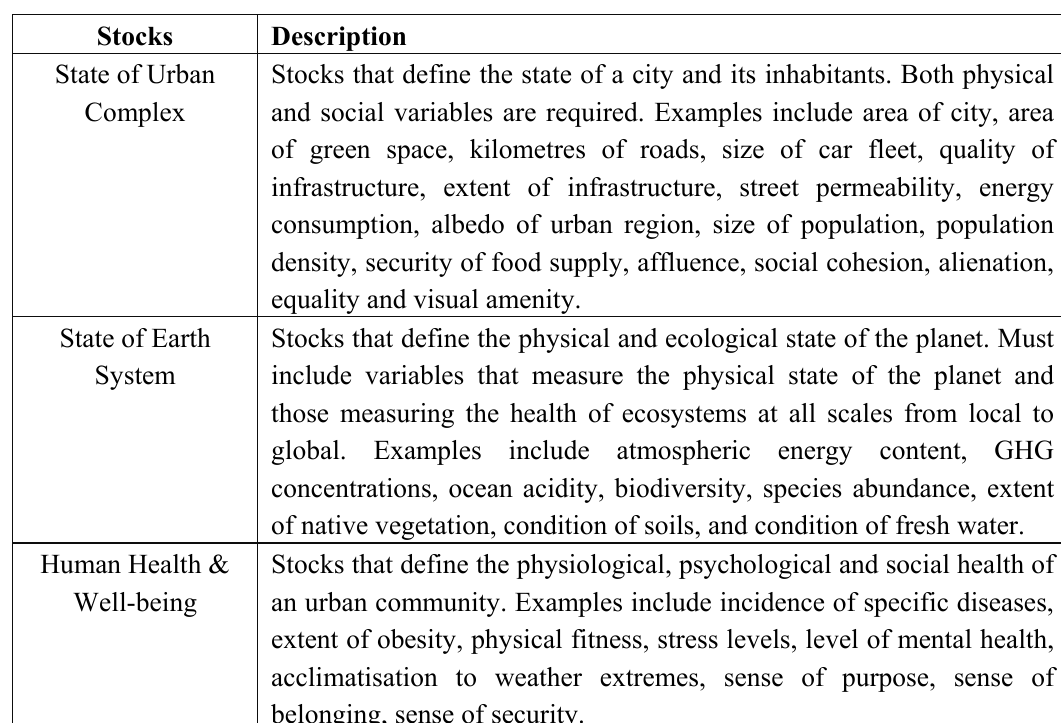
Table 1. The stocks of Figure